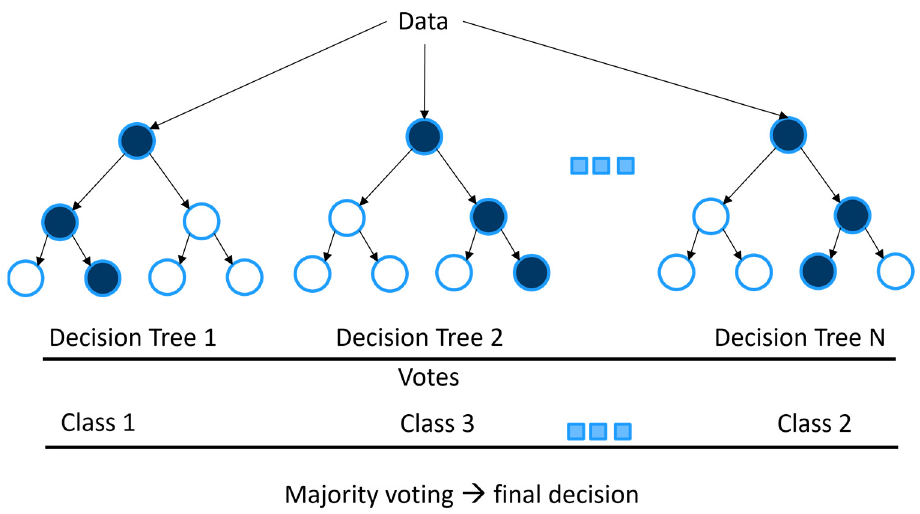
Figure 2. Schematic diagram of Random Forest (RF), the final decision inferred from majority voting using results from each decision tree.